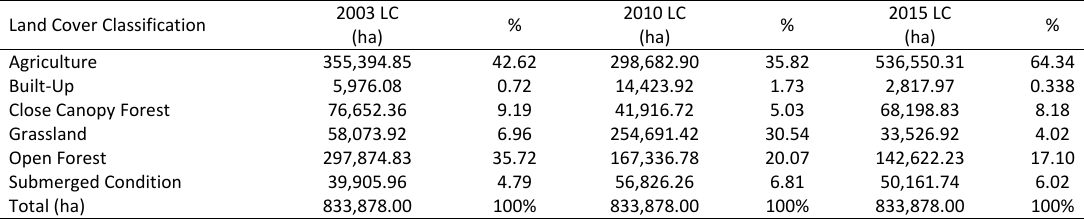
Table 2. Land cover proportion of 2003, 2010 and 2015 (Namria and Geo-SAFER, 2019) Land Cover Classification